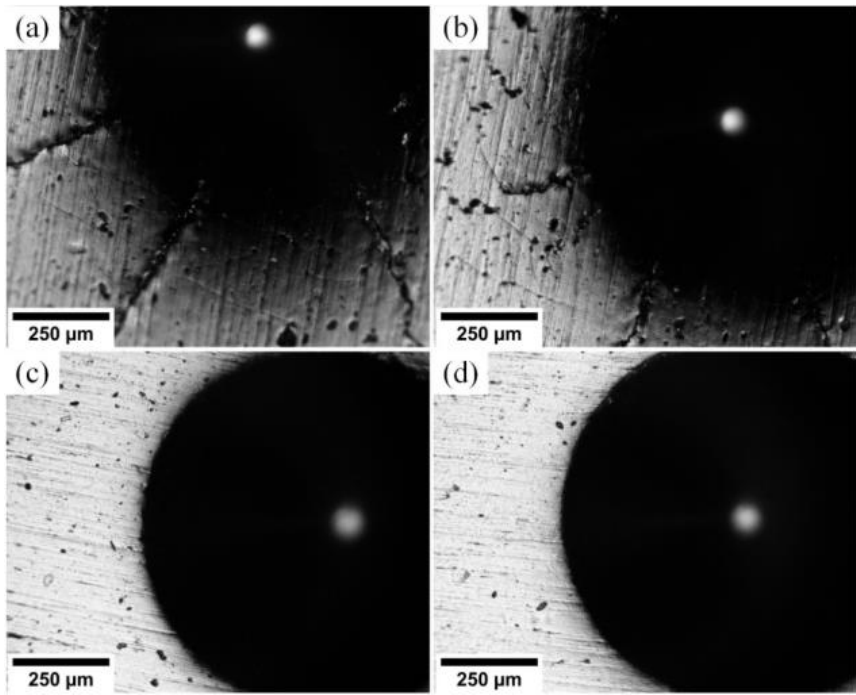
Figure 13. Rockwell indentation images of substrates: ( a ) S1 (Al/Cr = 1.2), ( b ) S2 (Al/Cr = 0.8), ( c ) S3 (Al/Cr = 0.5), ( d ) S4 (Al/Cr = 0.2).